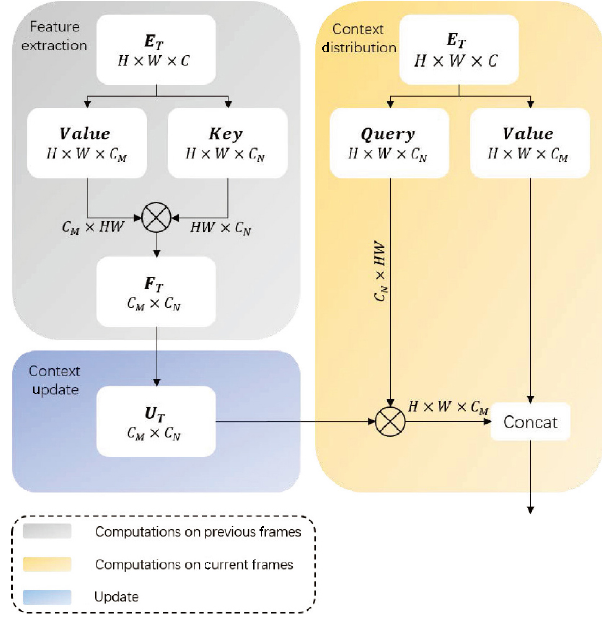
Fig. 3 Context distribution